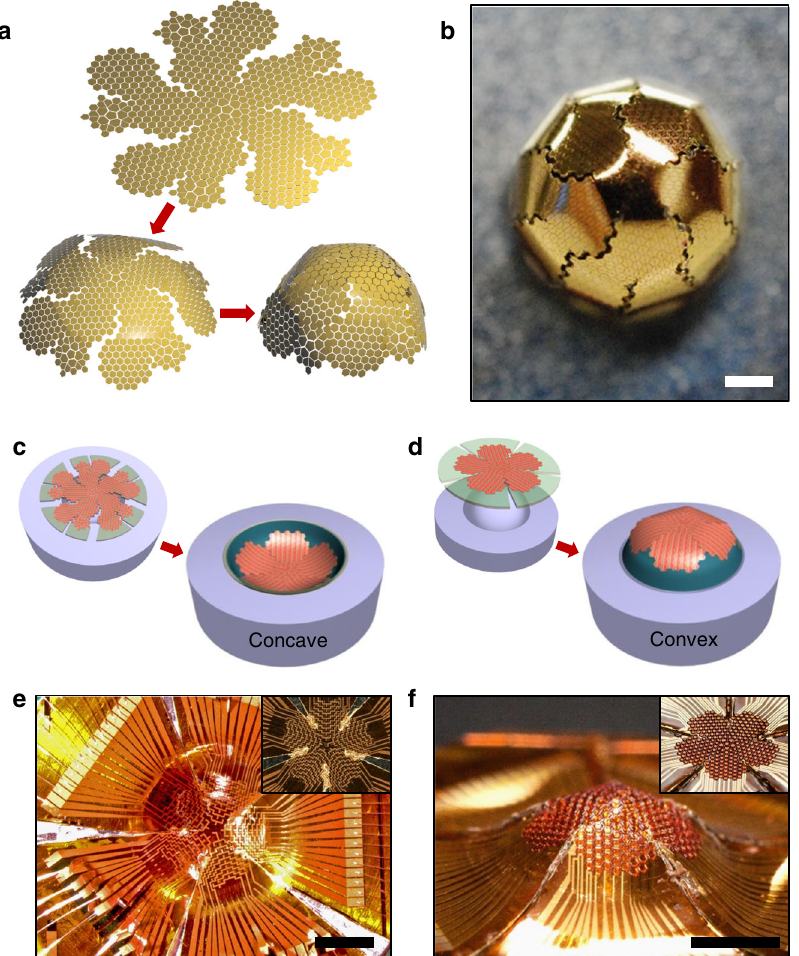
Fig. 1 Geometric origami of silicon optoelectronics for the hemispherical electronic eye. a Schematic illustration of the net of half truncated icosahedron being folded into a hemisphere. 676 polygon blocks consisting of pentagons and hexagons were mapped into a net of subdivided half truncated icosahedron which was then folded to form a hemisphere. b A photograph of the half truncated icosahedron based on polygon blocks of metal-coated silicon nanomembranes printed on a fl exible polyimide fi lm. The completed net was folded into a convex hemisphere by inserting the net into a circular hole of a metal fi xture. Scale bar, 1 mm. c Schematic illustration of the net of half truncated icosahedron based on silicon nanomembranes pressed into a hemispherical concave mold. d Schematic illustration of the net of half truncated icosahedron based on silicon nanomembranes covered on a hemispherical convex mold. e A photograph of a silicon optoelectronics-based hemispherical focal plane array formed using the concave mold-based origami approach shown in c . Inset image shows the fl at focal plane array before folding. Scale bar, 2 mm. f A photograph of a silicon optoelectronics-based convex hemispherical eye camera formed using the convex mold-based origami approach shown in d . Inset image shows the fl at eye camera before folding. Scale bar, 2